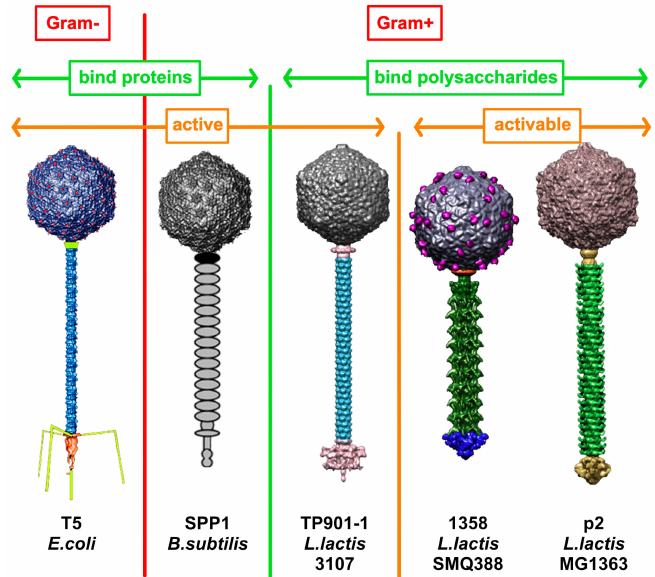
Figure 1. Examples of siphophages infecting Gram-positive and Gram-negative bacteria. Phages are classified between those binding to host-encoded proteins (green, left) or cell wall polysaccharides (green, right) and those with a ready to bind adhesion device (orange, left) and those with an activable adhesion device (orange